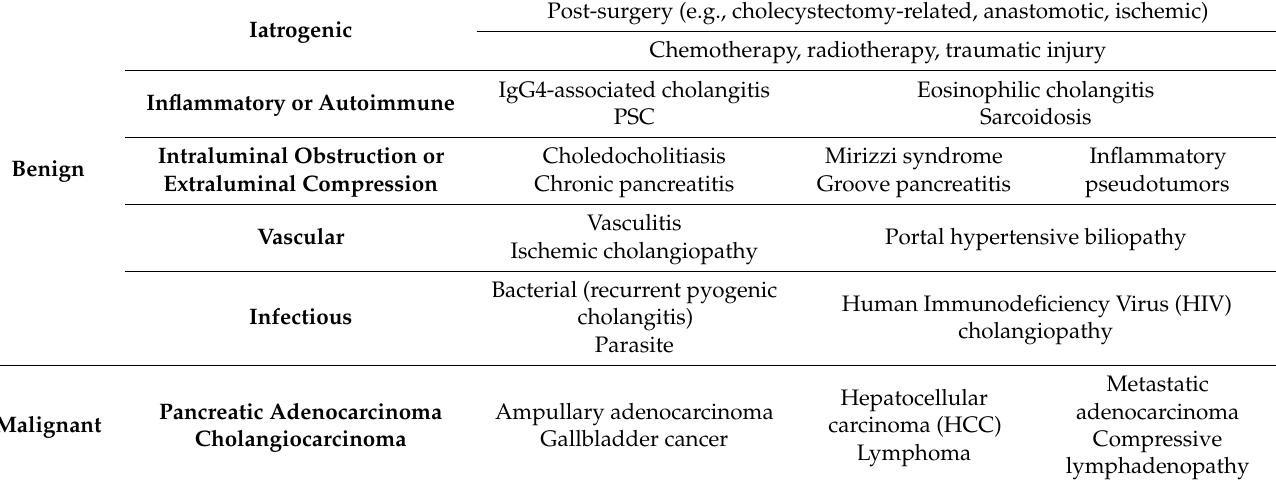
Table 2. Potential diagnoses of indeterminate biliary